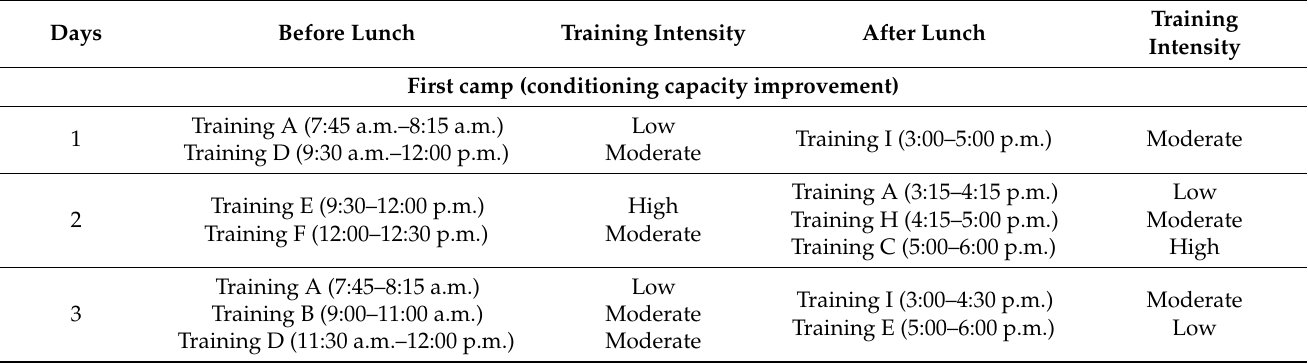
Table 1. Training programs during first and second